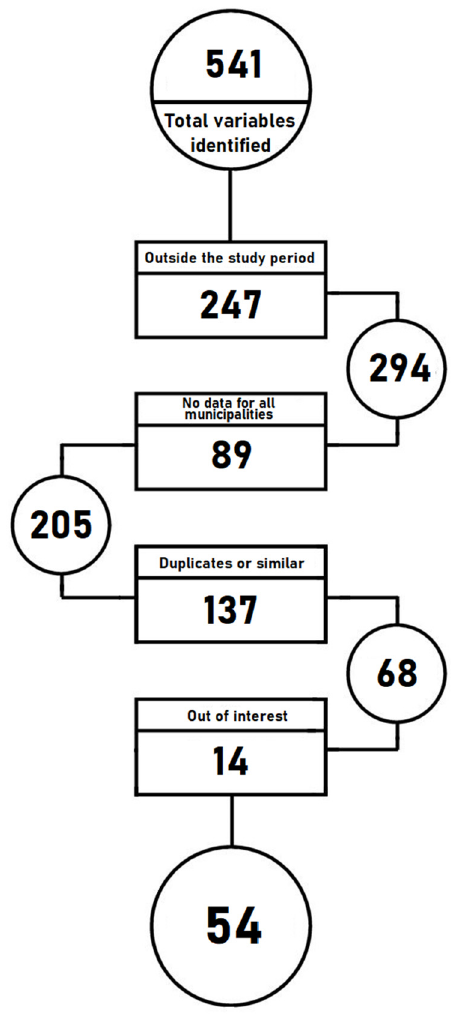
Figure 1. Debugging the process of all the detected variables up to the final data model. Source: authors’ own elaboration.